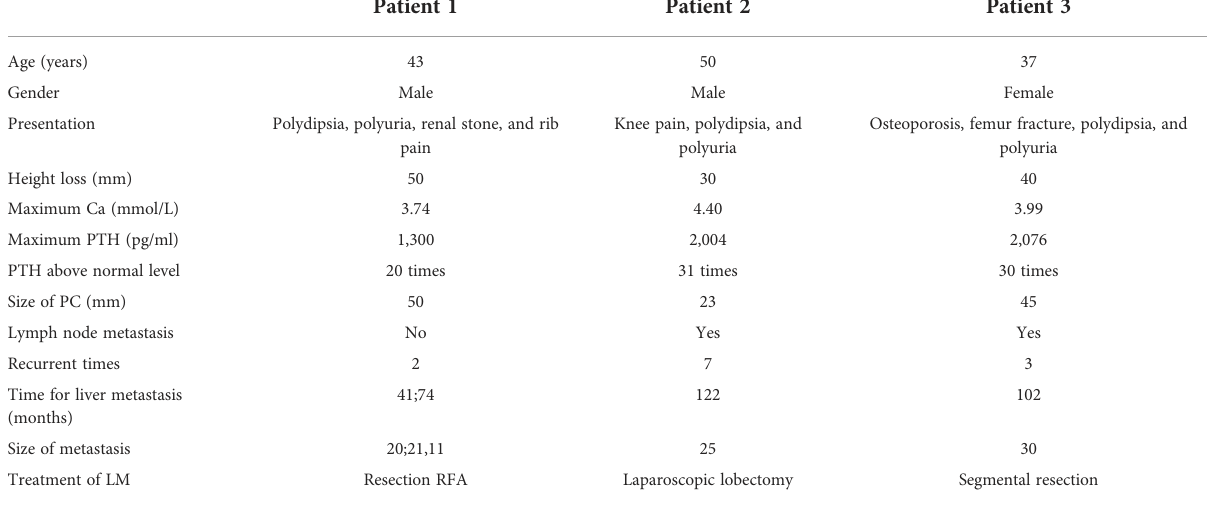
TABLE 1 Clinical presentation of the three